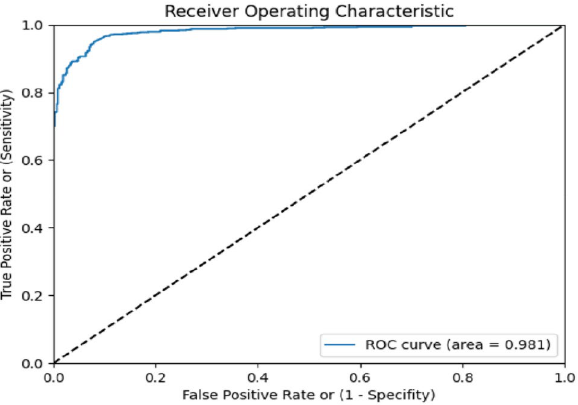
Figure 4. The representative graph for ROC curve, best among tenfold validation of TB prediction model built using derivation data.